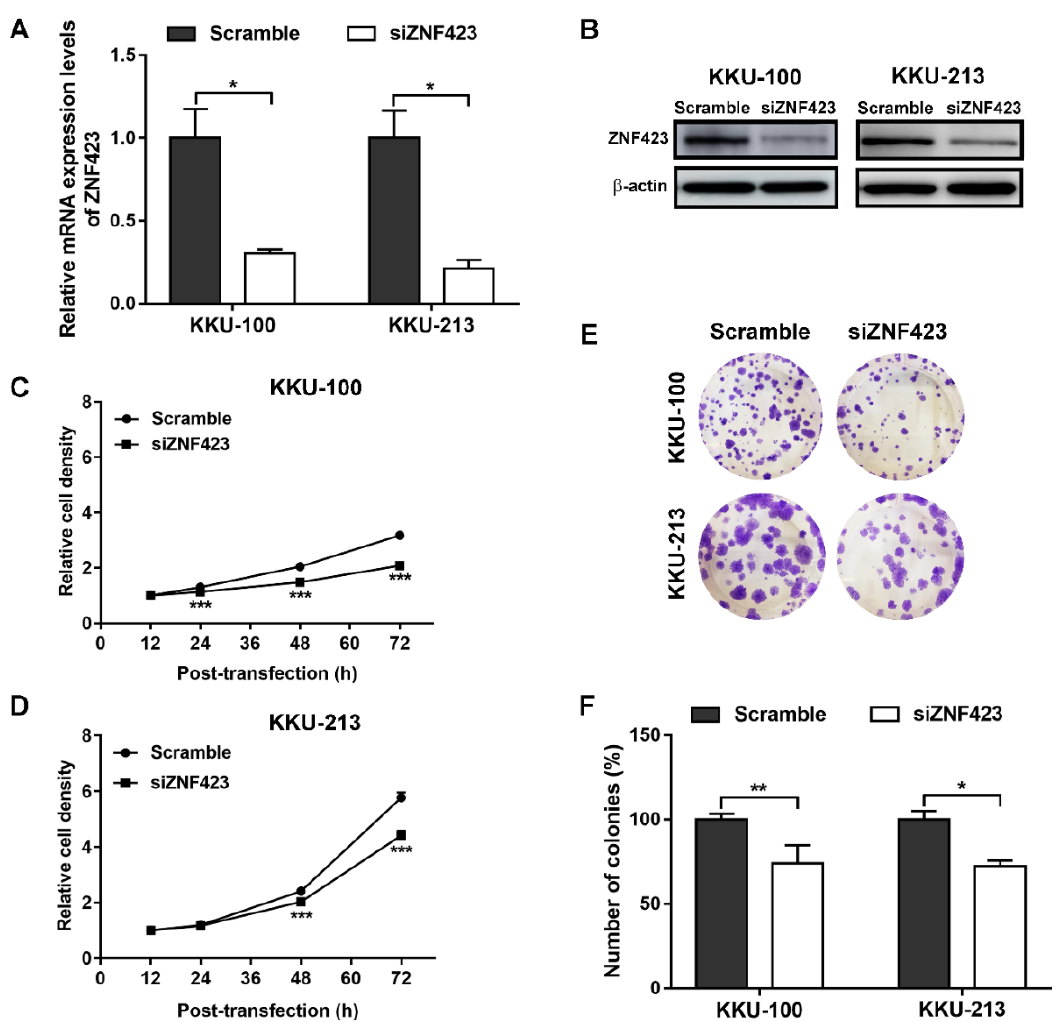
Figure 3. Effects of ZNF423 silencing on CCA cell proliferation and invasion. ZNF423 mRNA ( A ; n = 2 per condition) and protein (~100 kDa) ( B ) Expression levels, in KKU-100 and KKU-213, of siRNA-treated and scramble-treated KKU-100 and KKU-213 cells were measured using Quantitative Real-Time PCR (qPCR) and western blot analysis and normalized by β -actin (~42 kDa) expression levels. ( C , D ; n = 5 per condition) Relative cell density analyzed by SRB assay in KKU-100 and KKU-213 cells. ( E ) The crystal violet-stained KKU-100 and KKU-213 cells after cell re-seeding for 10 and 14 days. ( F ; n = 2 per condition) Relative number of colonies (%) in KKU-100 and KKU-213 cell lines. P -values were calculated by Student’s t test compared with scramble conditions (* p < 0.05, ** p < 0.01, and *** p < 0.001).